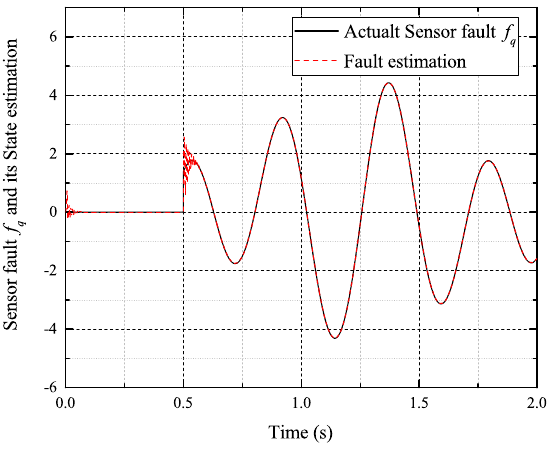
Figure 21. Sensor fault f q and its estimated value ˆ f q .